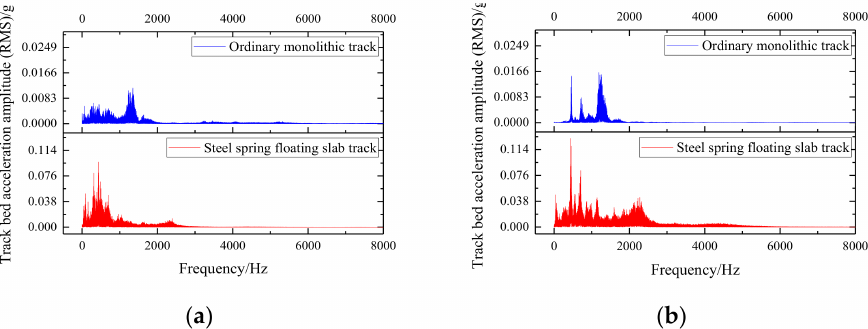
Figure 14. Comparison of vertical frequency spectrum of track bed. ( a ) Straight line segment; ( b ) curved segment.